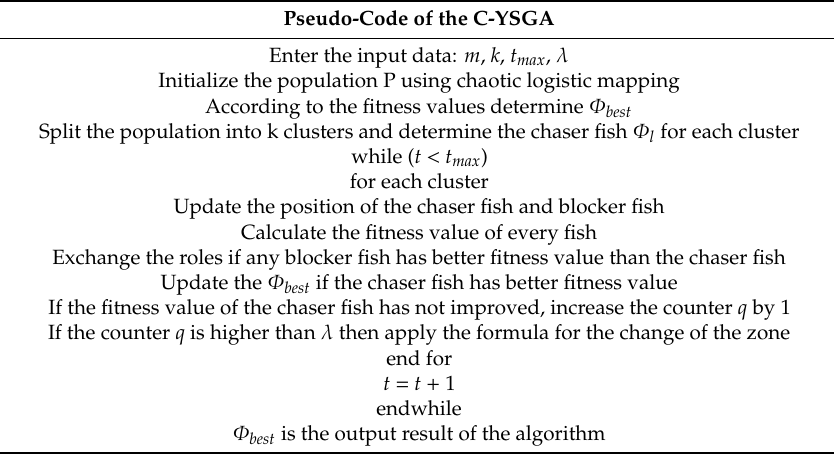
Table 5. Pseudo-code of the proposed